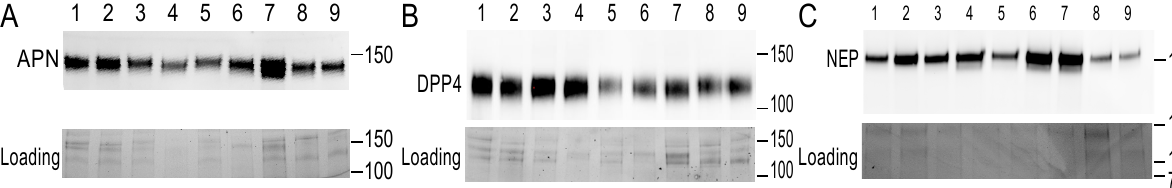
Figure 3. Presence of proteins of interest (above) and their loading controls (below) in seminal plasma samples. Western blot was used to determine the level of APN ( A ), DPP4 ( B ), and NEP ( C ) (males indicated by numbers 1–9). The position of the molecular weight standard (kDa) is shown on the right side of each panel. The blots shown here represent two other replicates based on a visual inspection of all the blots ( n = 3 replicates, in total).